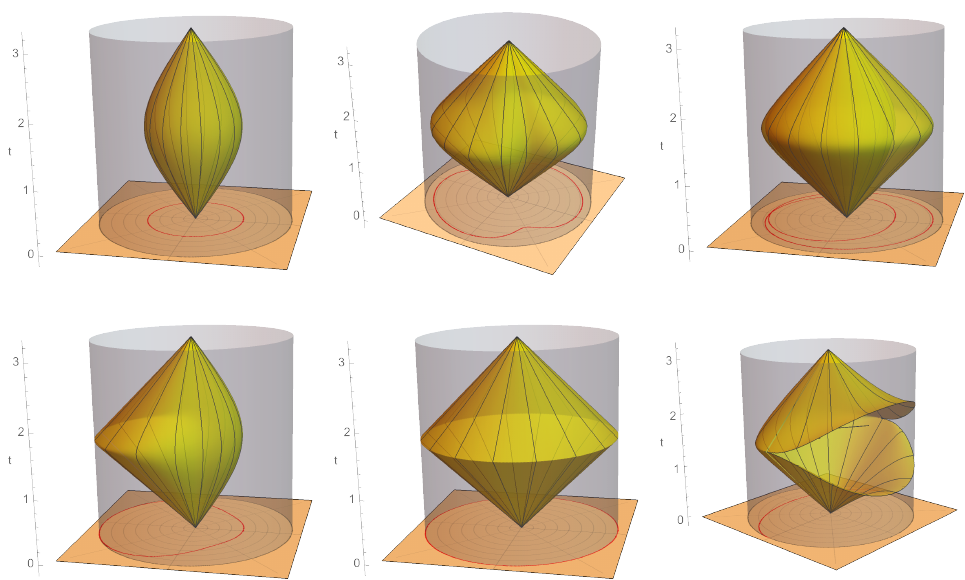
Figure 13: Gallery of generalised lemons. In each plot, we use the coordinate system of (87), where the AdS-boundary is mapped to the grey cylinder at θ = π/ 2. The time axis is shown explicitly. Each yellow surface is an embedding described by (94), with individual timelike geodesics shown as grey lines. In the t = 0 plane, the red line indicates the shape of the cut through the surface at its equator. What all of these surfaces have in common is the existence of tips with conical singularities, as